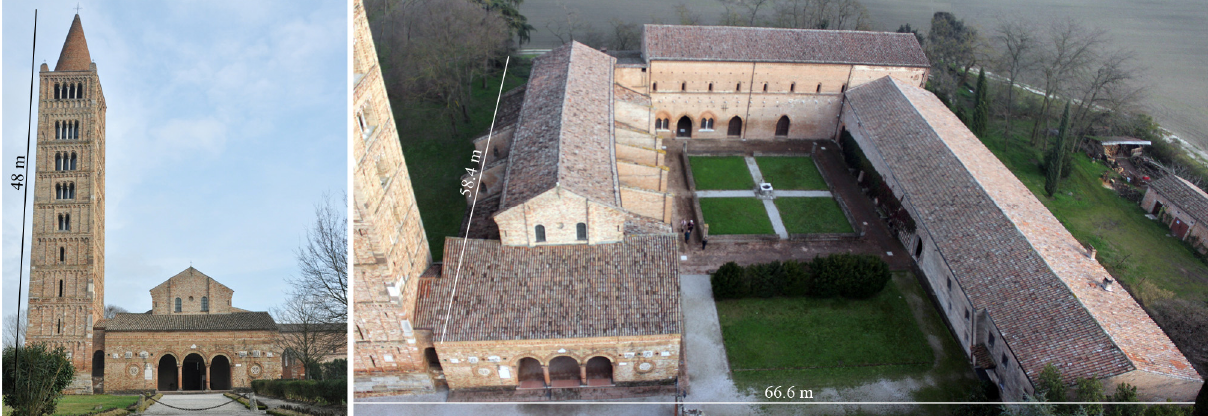
Figure 1. Images of the whole Abbey complex and its